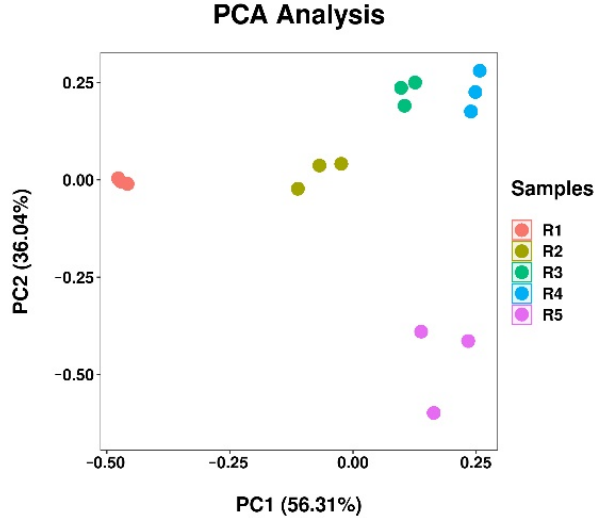
Figure 5. Principal component analysis of soil bacterial community. R1, R2, R3, R4, and R5 represent planting years for 1, 2, 3, 4, and 5 years, respectively.